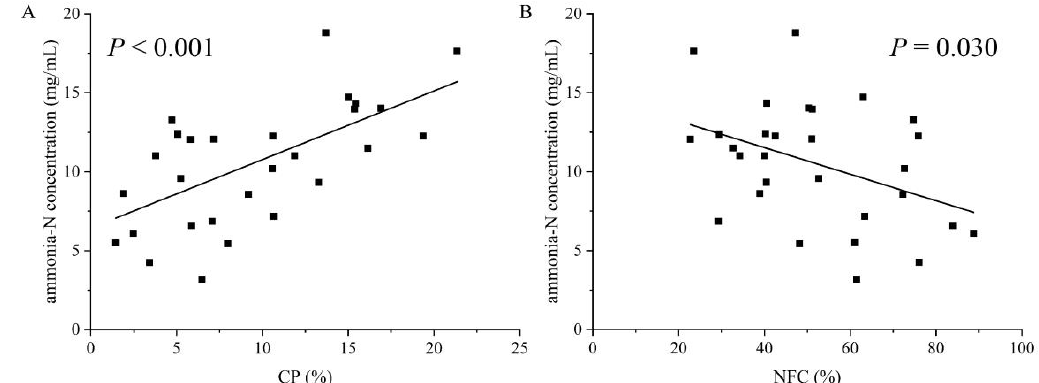
Figure 5. Correlation analysis of ammonia-N concentration with crude protein (CP; ( A )) and non-fiber carbohydrates (NFC; ( B )). p < 0.05 indicates significant correlation.